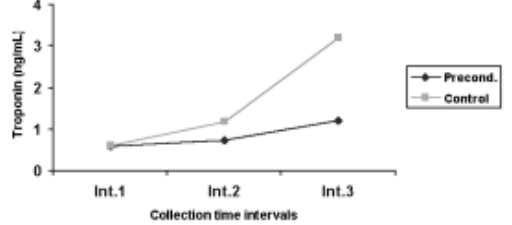
Fig. 2 - Evolution of Troponin I at the different time intervals of collection for the Control and Precondition groups Int. 1 – Initiation of cardiopulmonary bypass Int. 2 – After the first anastomosis